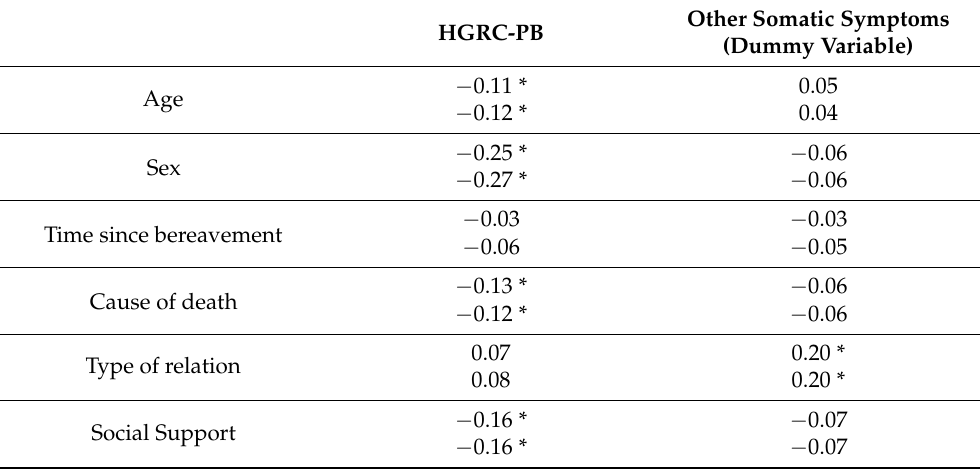
Table 1. Pearson (first line)/Spearman (second line) correlations between the control variables and the somatic complaints (HGRC-PB, dummy variable).